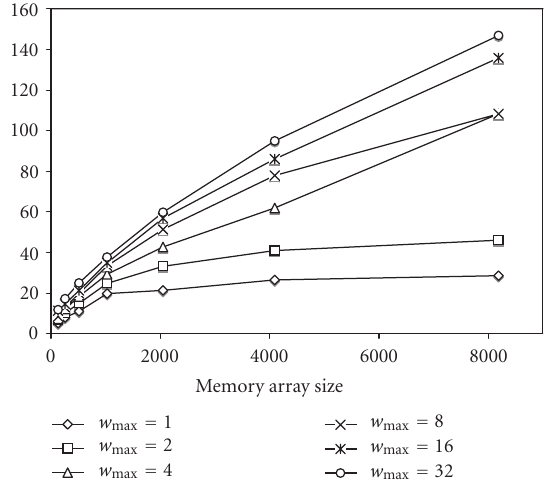
Figure 9: Impact on amount of packable LUTs when increasing memory size.